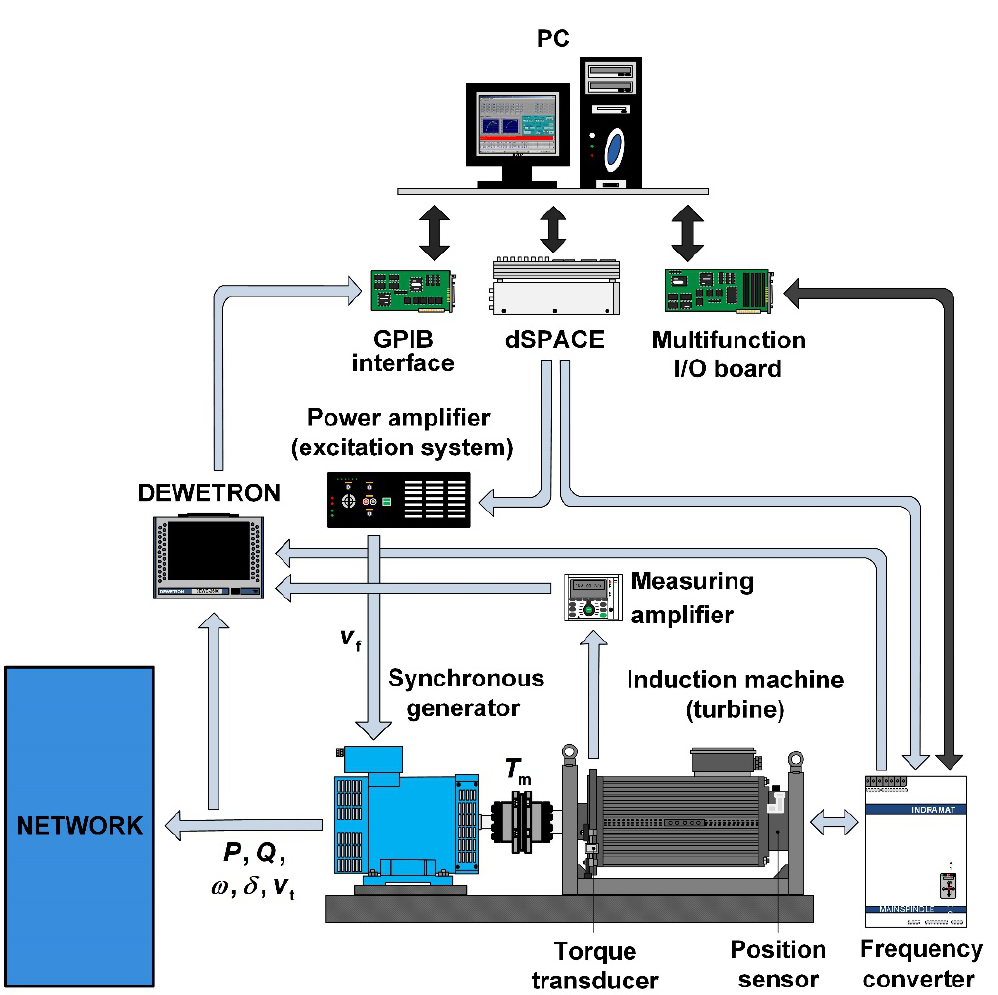
Figure 20. Laboratory experimental system.